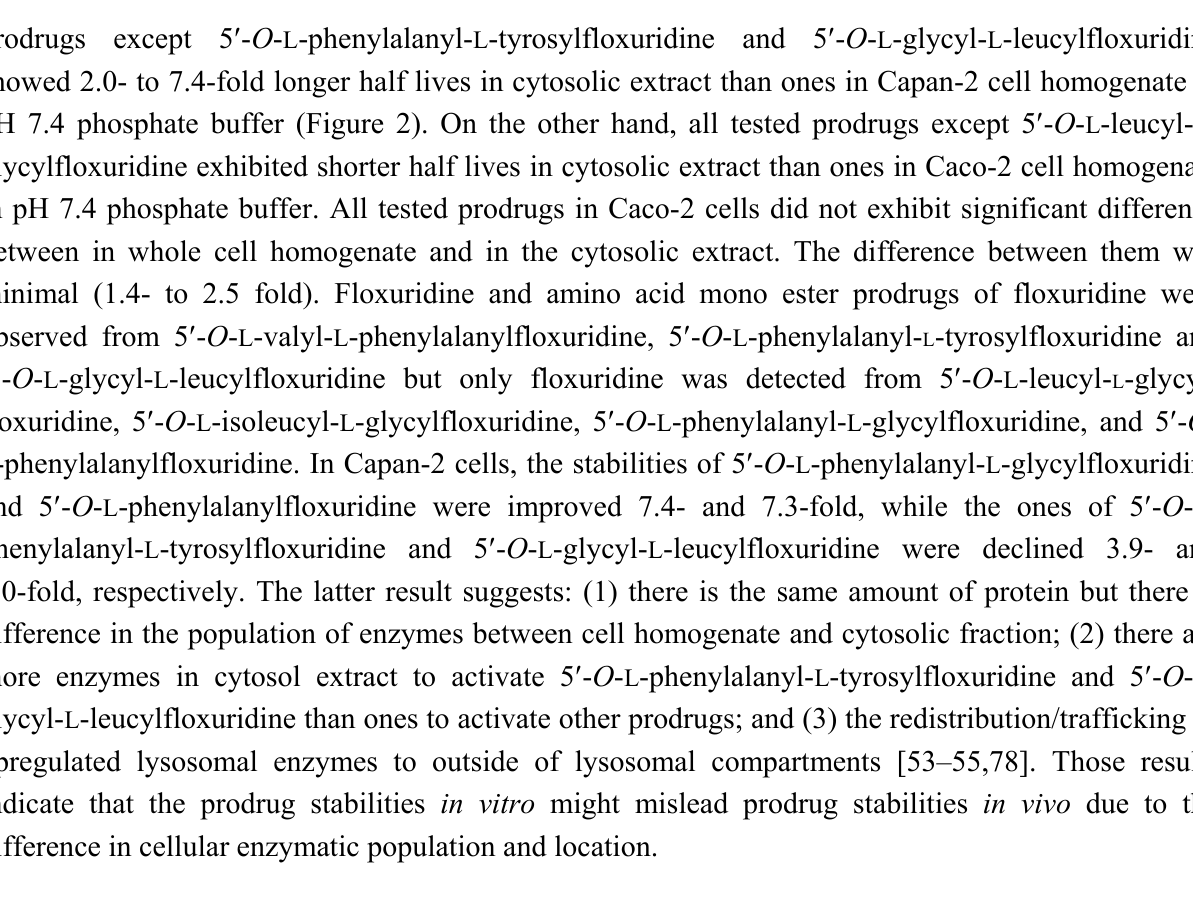
Figure 1. Prodrug stability in human cathepsin B and D. Values presented are the mean ± s.d., n = 4, (* p < 0.01; t